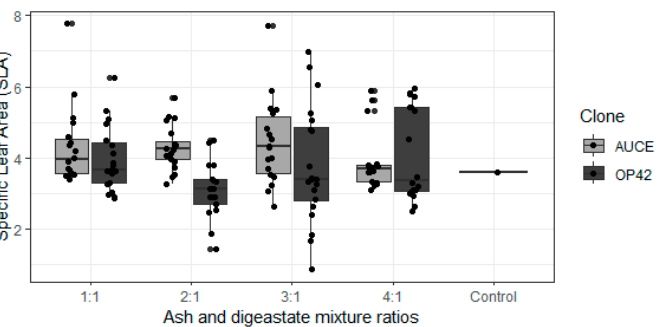
Figure 4. Specific Leaf Area (SLA) depending on ratio of the wood ash and digestate and poplar clone.